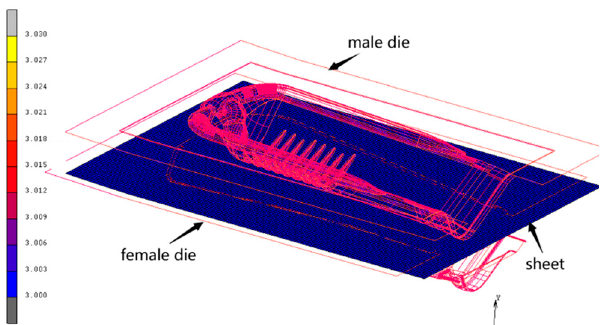
Figure 3. Male dies of ( a ) the preforming process; ( b ) final forming process. The numerical simulation of the forming process was carried out by the MSC.MARC